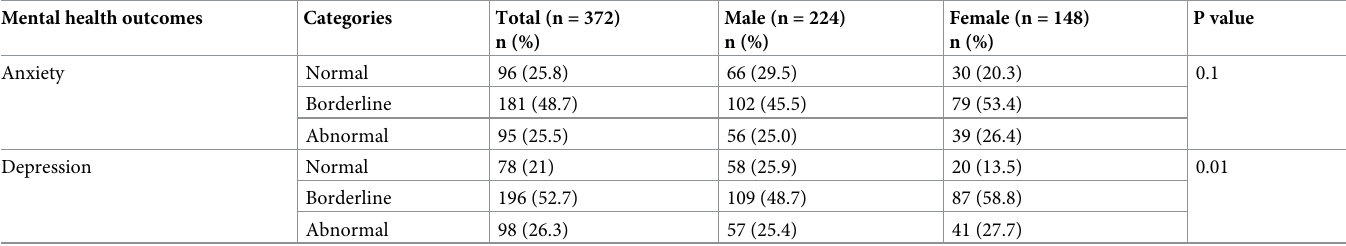
Table 1. Prevalence of anxiety and depression among study participants by gender. Mental health